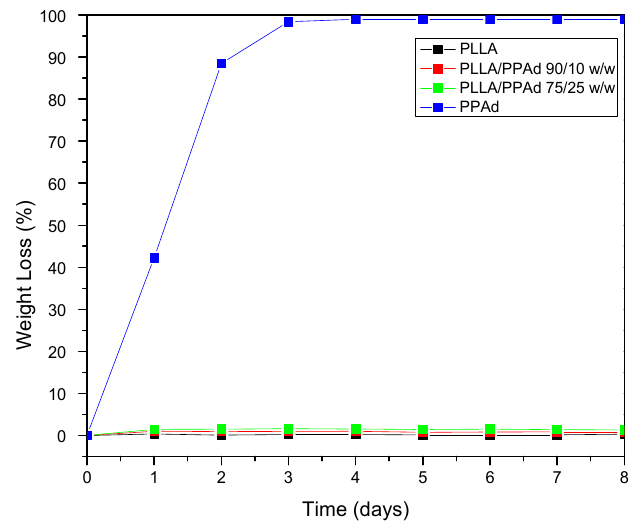
Figure 8. Weight loss versus time of neat PLLA, neat PPAd and PLA/PPAd copolymers at various weight ratios during hydrolysis test in the presence of enzymes at 37 °C and pH 7.